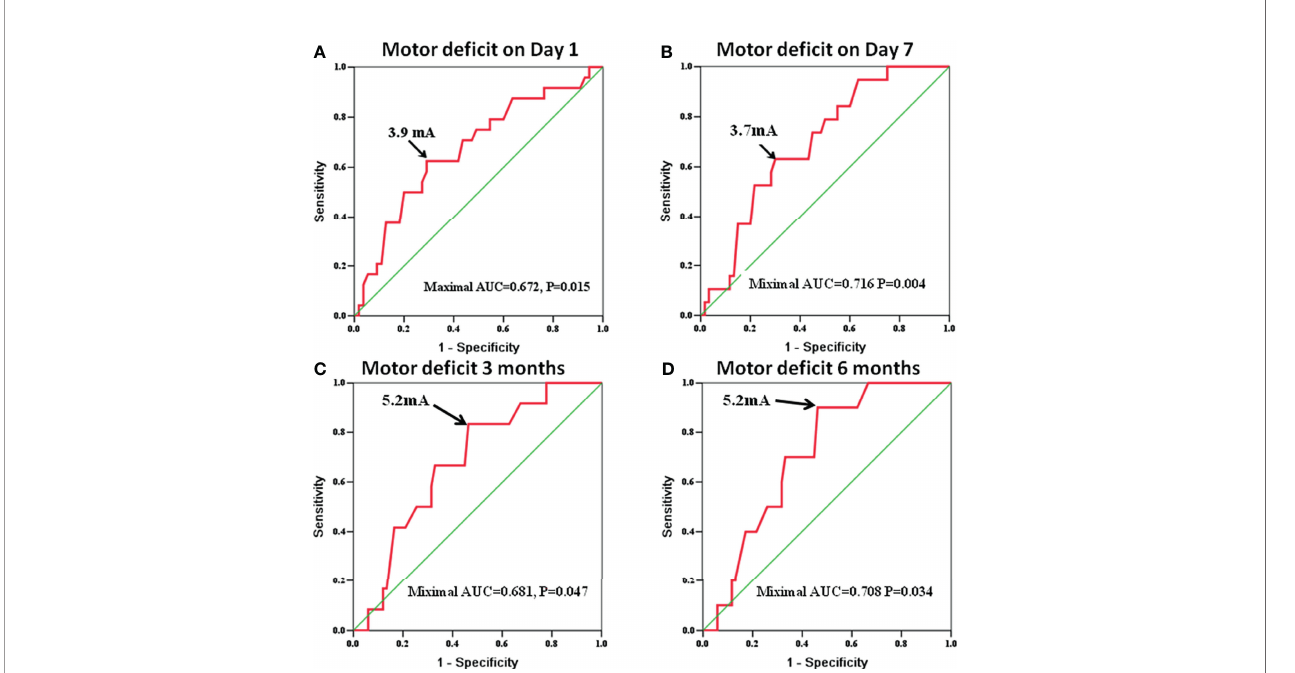
FIGURE 1 | The receiver operating characteristic (ROC) curve identi fi es that the cutoff subcortical monopolar threshold to predict motor de fi cit was 3.9 mA on day 1 [ (A) , P = 0.015], 3.7 mA on day 7 [ (B) , P = 0.004], 5.2 mA at 3 months [ (C) , P = 0.047], and 5.2 mA at 6 months after surgery [ (D) , P =